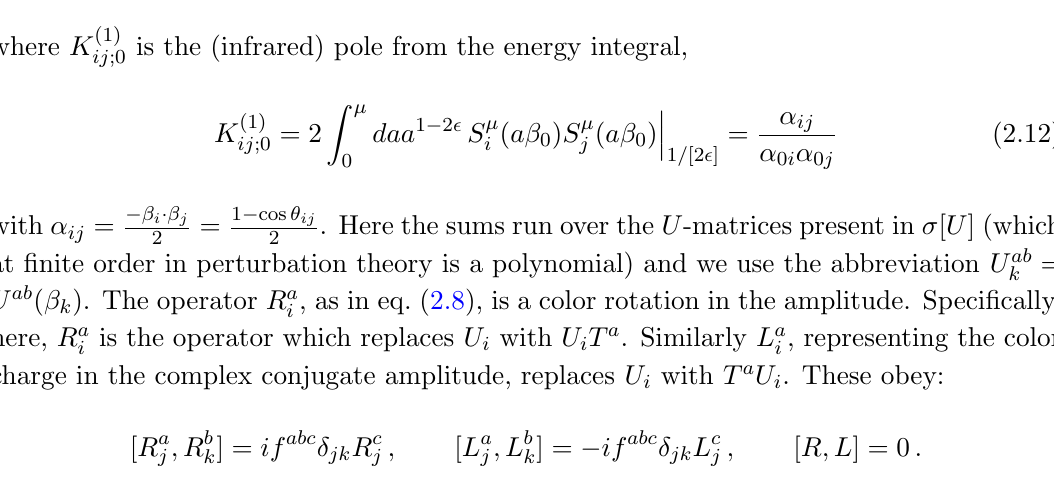
Figure 4 . One-loop evolution of the density matrix. (a) Real emission of one soft gluon. This adds one U -matrix (cf. eq. (2.11)). (b) Virtual